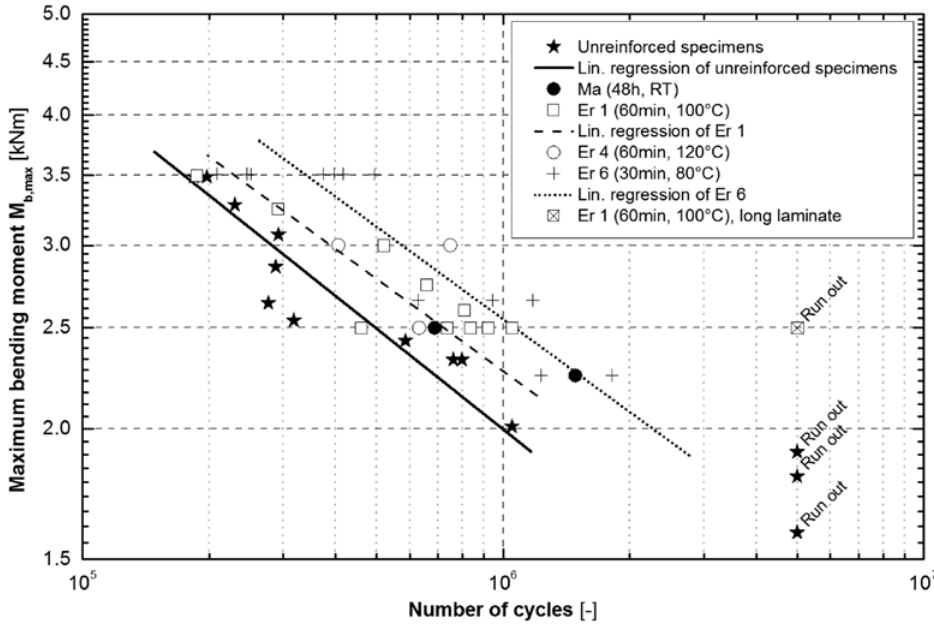
Figure 8. Fatigue lives of lap-shear-specimen bonded with different adhesive systems [28].